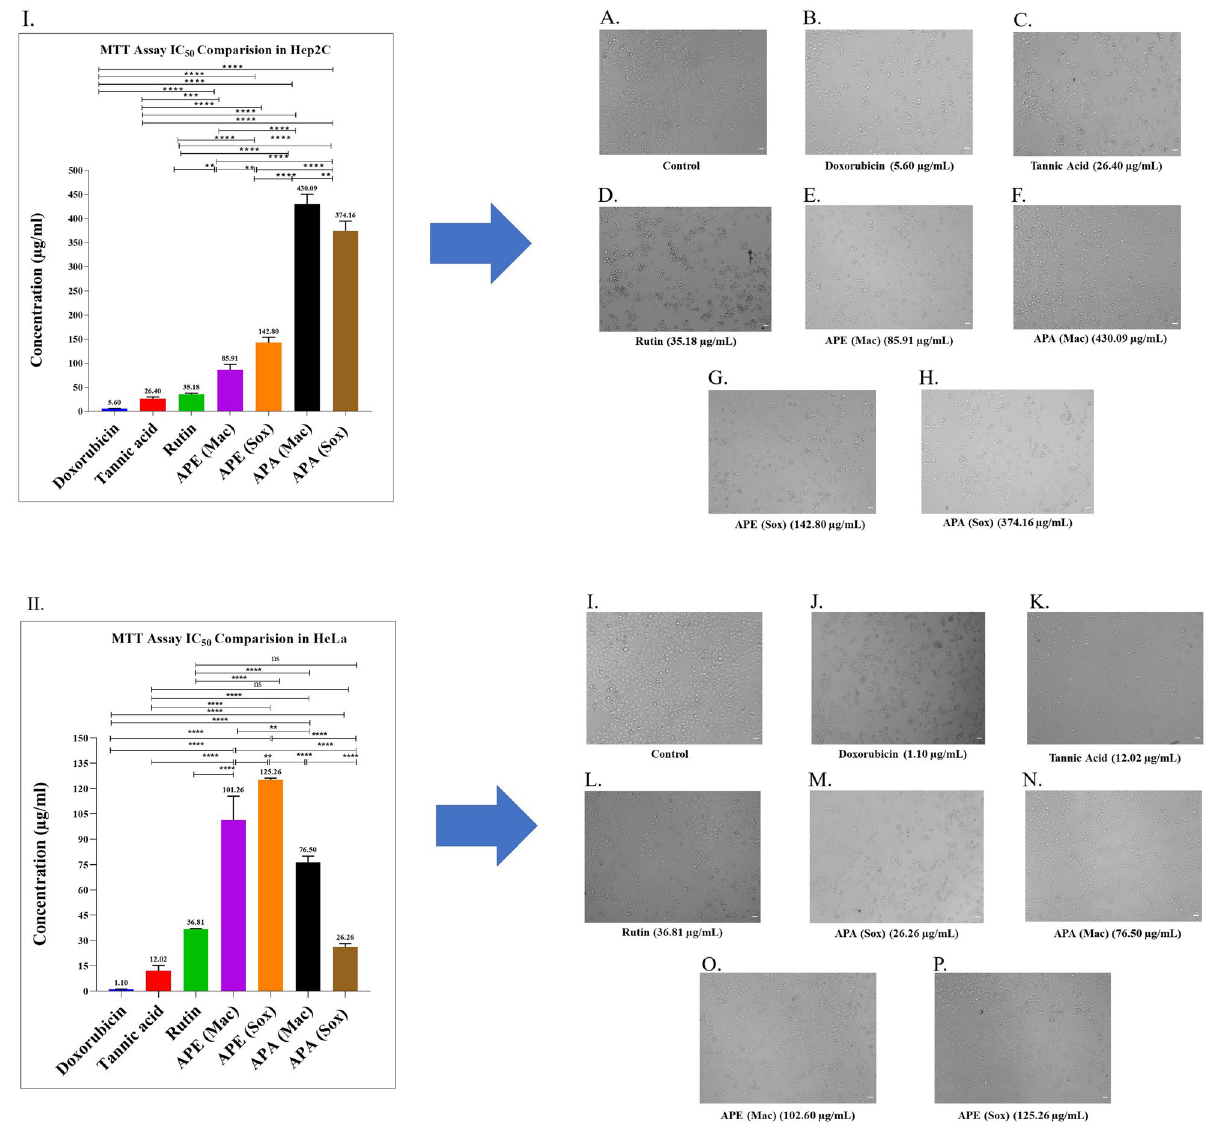
Figure 5. Antiproliferative activity on cervical cancer cells (Hep2C and HeLa): (I–II) ; The comparison of average IC 50 between A. precatorius seed extracts and standards (doxorubicin, rutin and tannic acid) over 48 h (Y-axis: concentration in (µg/mL)). The significance between various groups was tested using one-way ANOVA where: ns; non-significant, (*) p = 0.0308, (** p = 0.0014), (***) p = 0.0003, (****) p < 0.0001. (A–H) ; Morphological changes showing inhibition of Hep2C using IC 50 specific values of A. precatorius seed extracts and standards after 48 h . (I–P) ; Morphological changes showing inhibition of HeLa using IC 50 specific values of A. precatorius seed extracts and standards after 48 h. The cells were evaluated under an Olympus inverted microscope using 10X objective lens (magnification 100X). Scale bar: 100